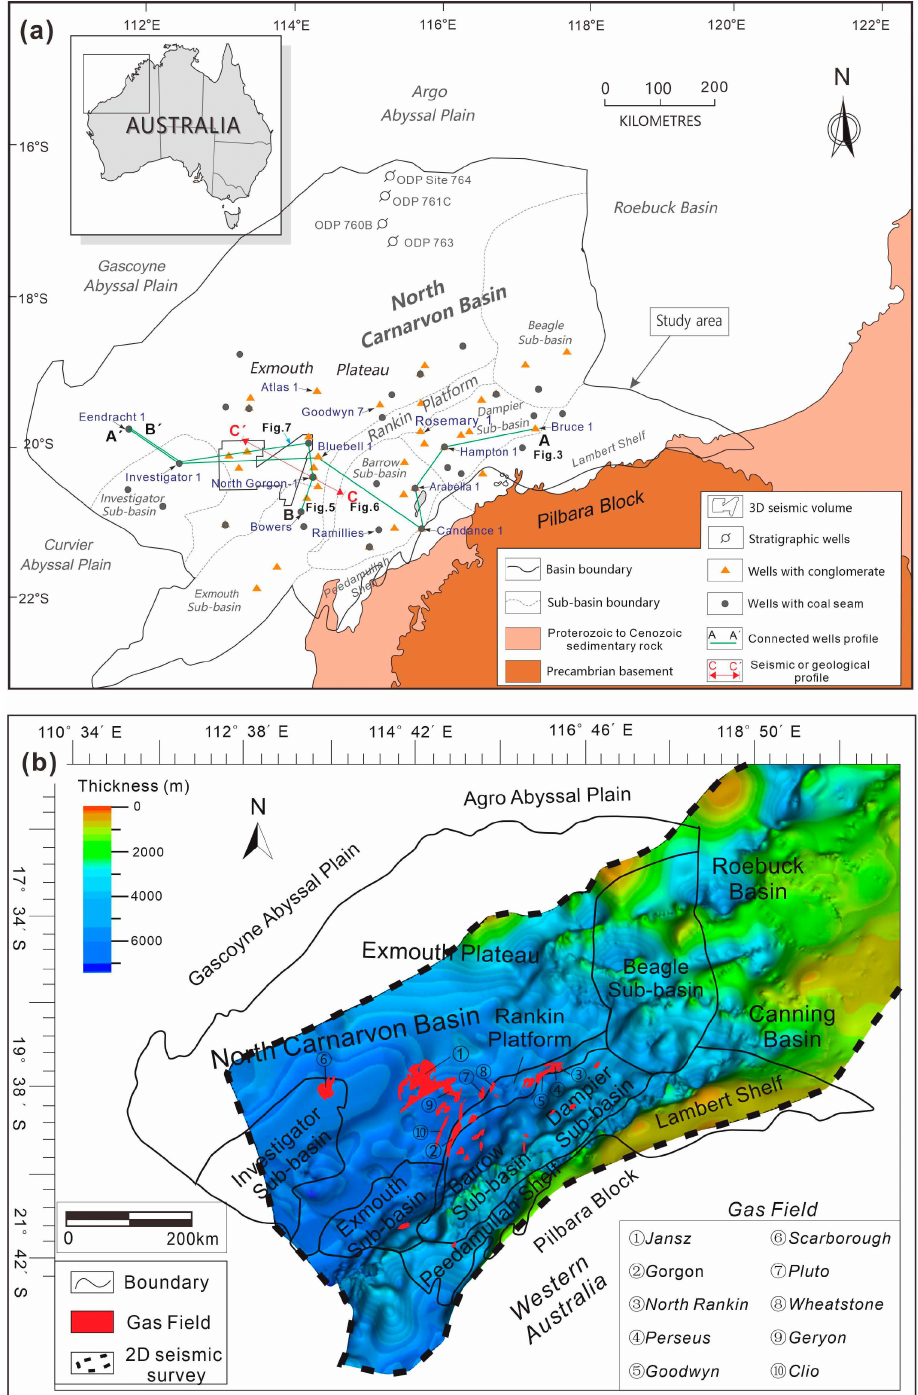
Figure 1. ( a ) Regional geological maps of the North Carnarvon Basin in the Northwest Shelf of Australia, including the drilled wells which penetrated the Triassic conglomerate or coal seam and the location of the connecting-well sections and seismic profile used in this study. ( b ) Thickness map of the Triassic strata in the North Carnarvon Basin and a series of significant gas field in this